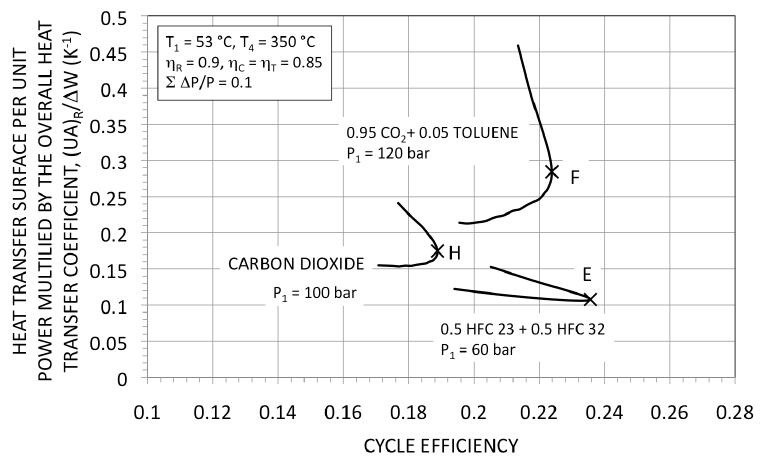
Figure 14. The heat transfer surface for the recuperator per unit power multiplied by the overall heat transfer coefficient as a function of the thermodynamic cycle efficiency for a carbon dioxide cycle and for two different